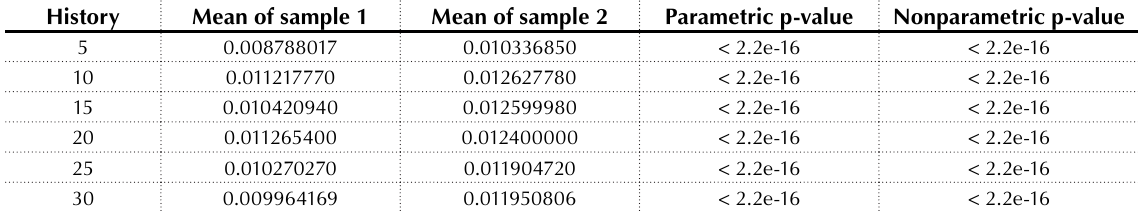
Table 4. Results of testing differences between